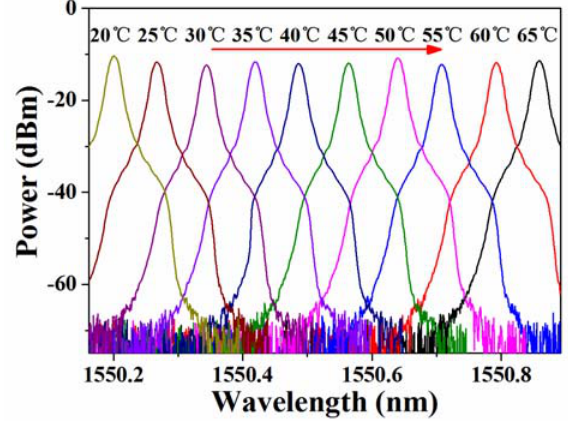
Figure 3. Output spectra of the single-frequency fiber laser at different temperatures.